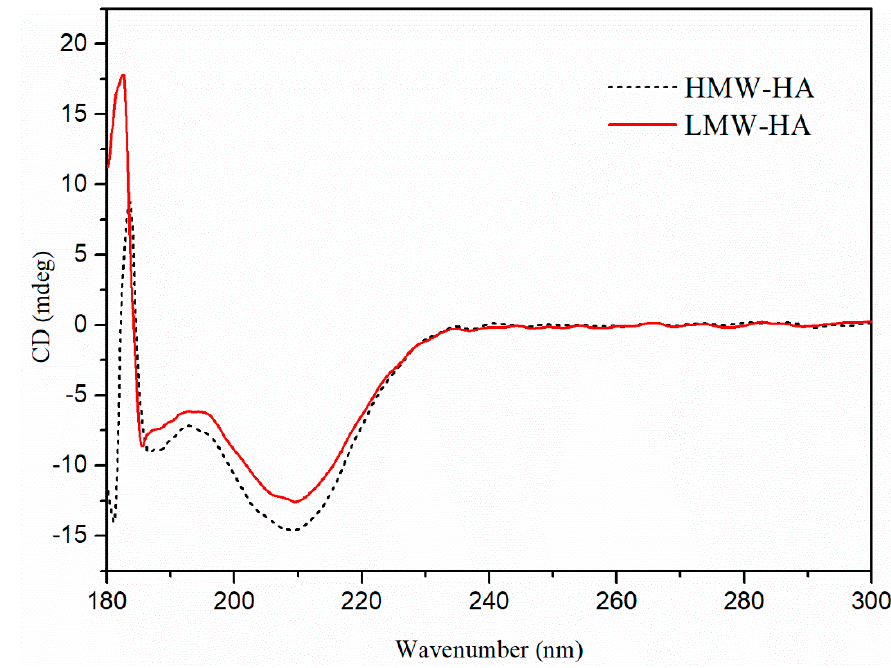
Figure 4. CD spectra of HMW-HA and LMW-HA.